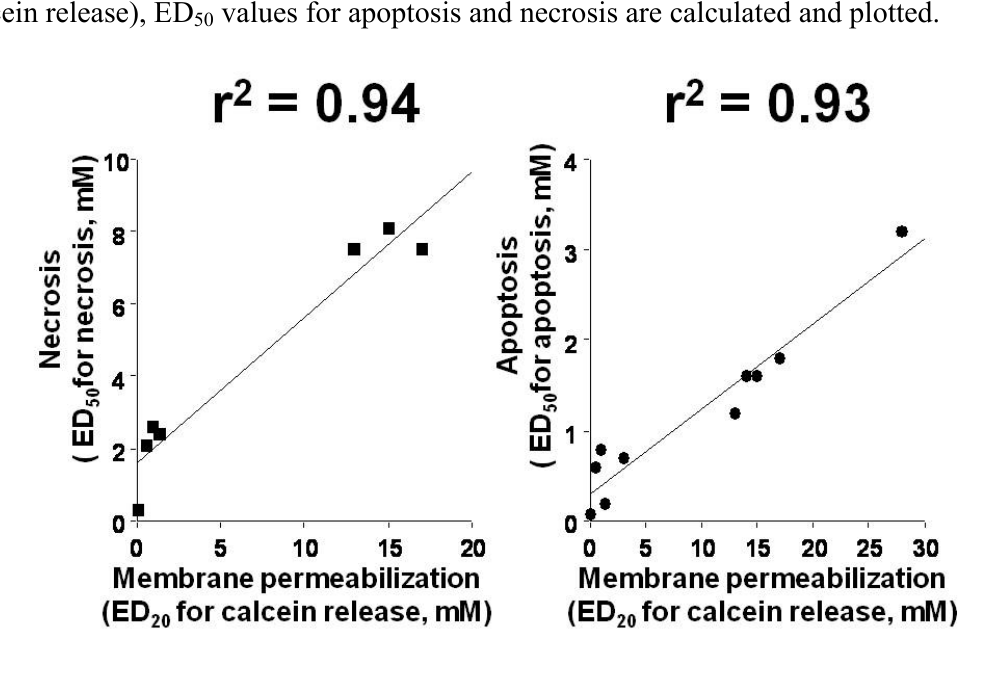
Figure 1. Relationship between necrosis- or apoptosis-inducing and membrane permeabilization activities of NSAIDs. ED values for membrane permeabilization 20 (calcein release), ED values for apoptosis and necrosis are calculated and 50